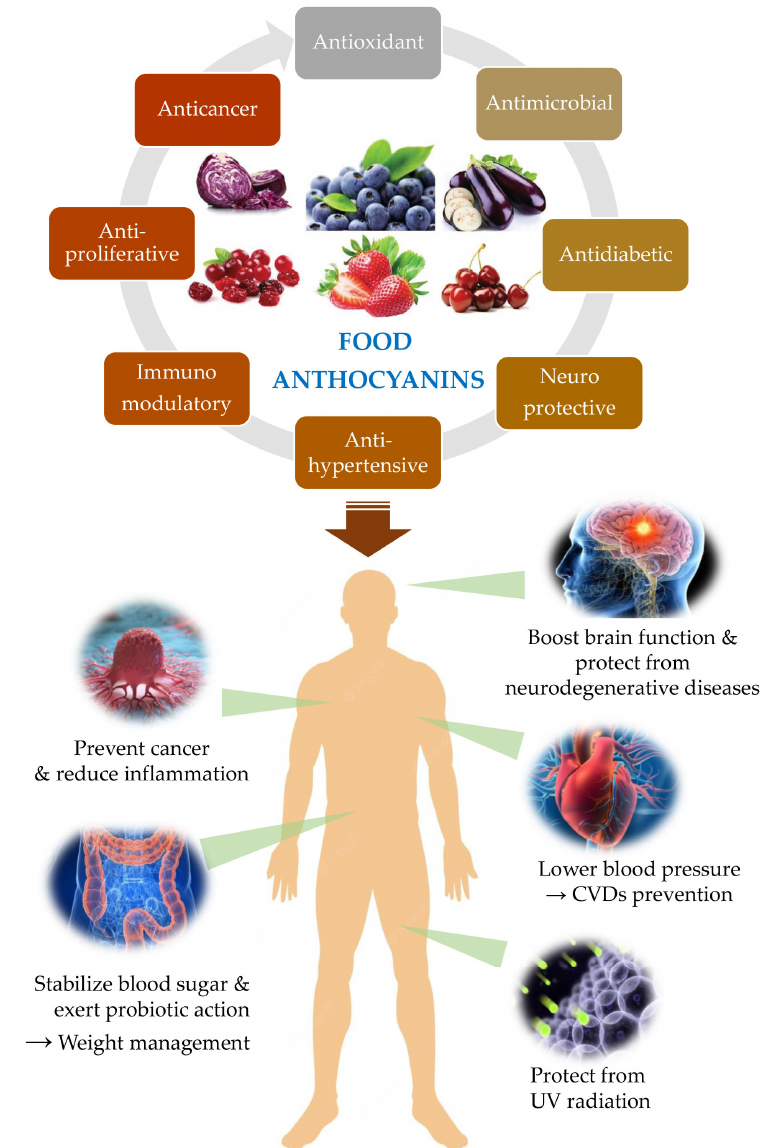
Figure 3. Overview of major human protective effects associated to ACNs consumption reported in the literature.